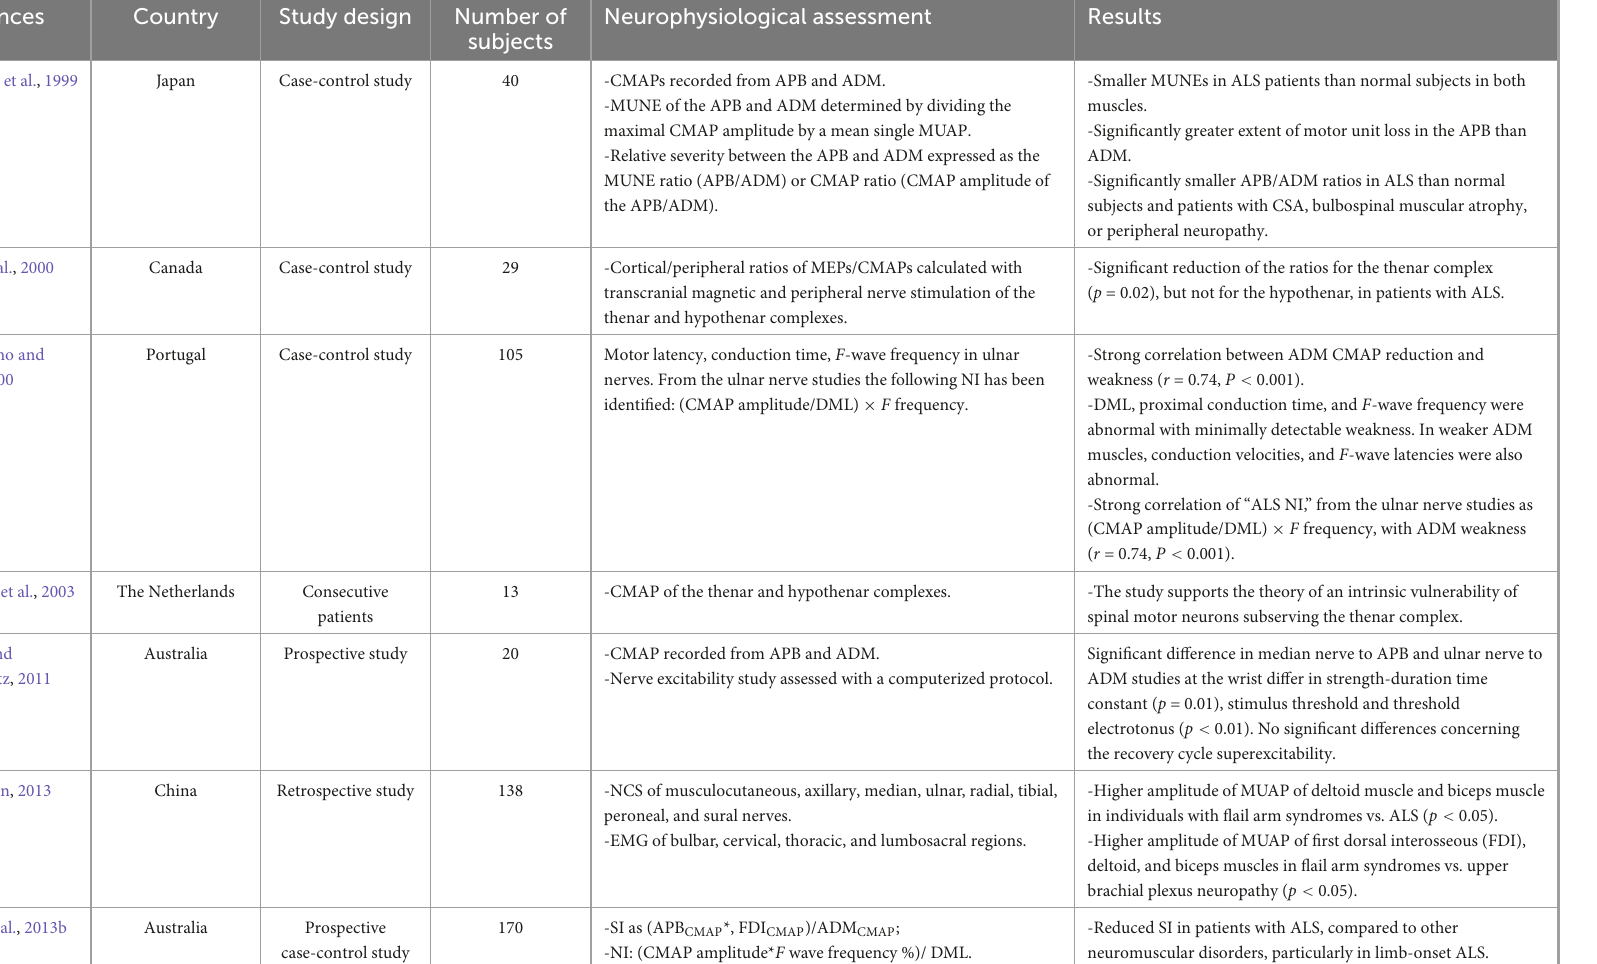
TABLE 1 Neurophysiological index (NI) of split-hand (SH) and split-leg signs